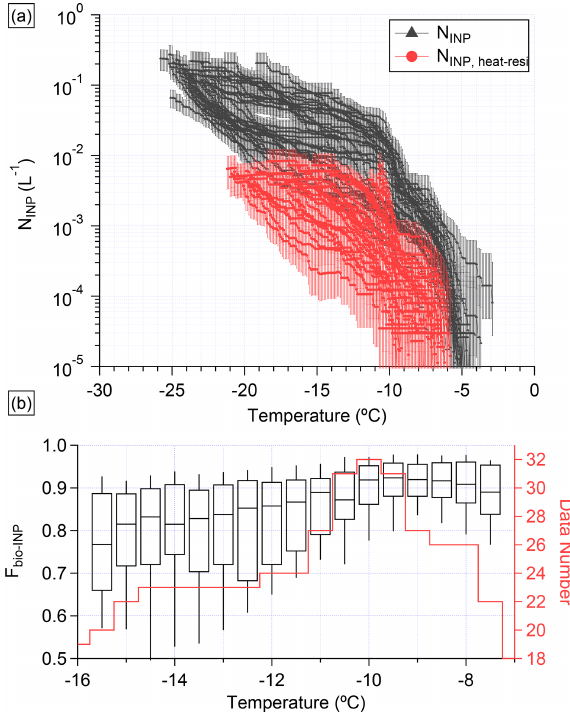
Figure 3. (a) Values for N INP and N INP, heat_resi as functions of temperature in black triangles and red dots, respectively. (b) Box- plot of F bio-INP as a function of temperature. The red line shows how many different samples contributed to the boxplot at different temperatures (relating to the right axis).